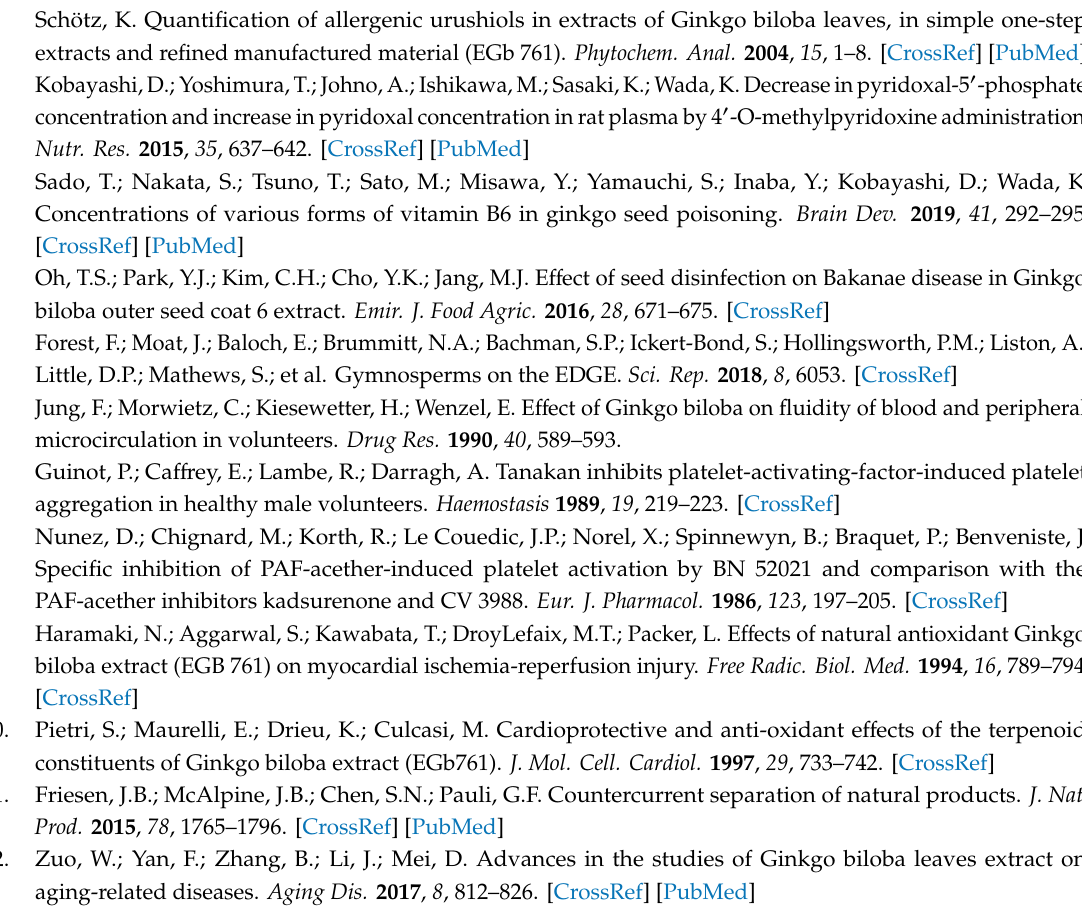
Figure S1: Changes in the consumption of drinking water containing various concentrations of ginkgo vinegar. Mice were given drinking water containing 0%, 2.5%, 5.0%, 7.5%, 10.0%, 12.5% or 15.0% ginkgo vinegar for 3 days. Consumption of the drinking water is illustrated as mL / day / mouse. Data represent mean ± SD ( n = 3). * p < 0.5, Dunnett’s test; Figure S2. Cytotoxicity of various concentrations of ginkgo vinegar (A) and acetic acid (B) on 3T3-L1 cells. 3T3-L1 cells were induced into adipocytes with MDI medium in the presence of 0.1–0.8% ginkgo vinegar (GV) or 0.005–0.04% acetic acid for 2 days. Cell viability was assessed by trypan blue dye exclusion test. Data represent mean ± SD ( n = 5). ** p < 0.01 vs. MDI; Table S1. E ff ect of ginkgo vinegar and HFD on serum cholesterol and triglyceride in mice. Mice were fed either normal chow (STD) or HFD with drinking water containing 0 (water), 2.5, 5.0 or 7.5% ginkgo vinegar (GV) for 10 weeks. Serum levels of total cholesterol (T-CHOL) and triglyceride (TG) were analyzed (mg / dL) in Fuji Film VET Systems Co Ltd. (Tokyo Japan). Date represent mean ± SD ( n =